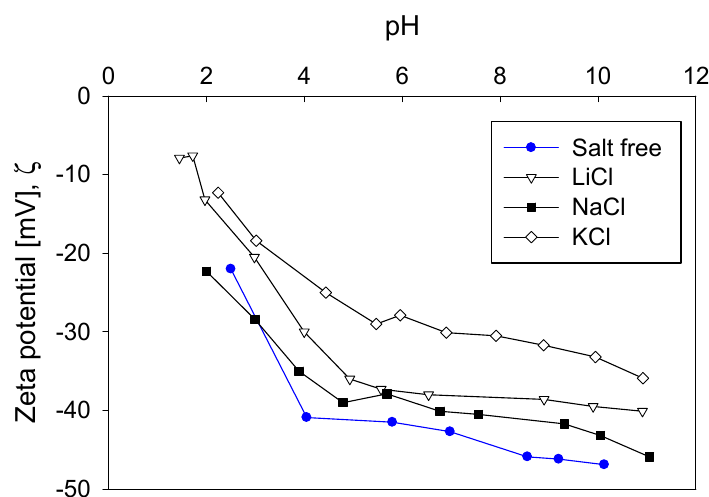
Figure 11. Impact of salt type (0.01 M) and pH on zeta potential of silica.